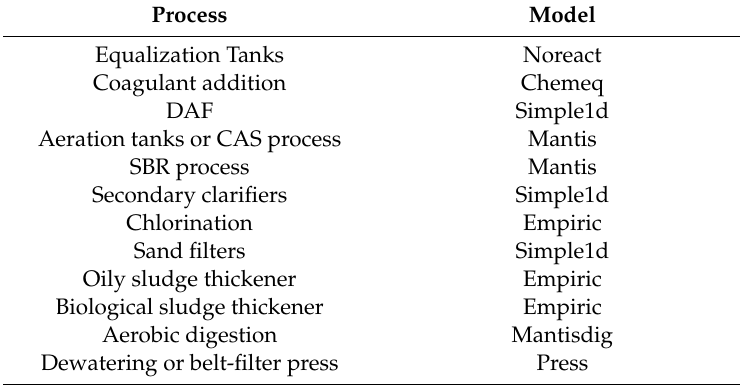
Table 5. The selected models used for di ff erent unit operation in PRWWTPs for